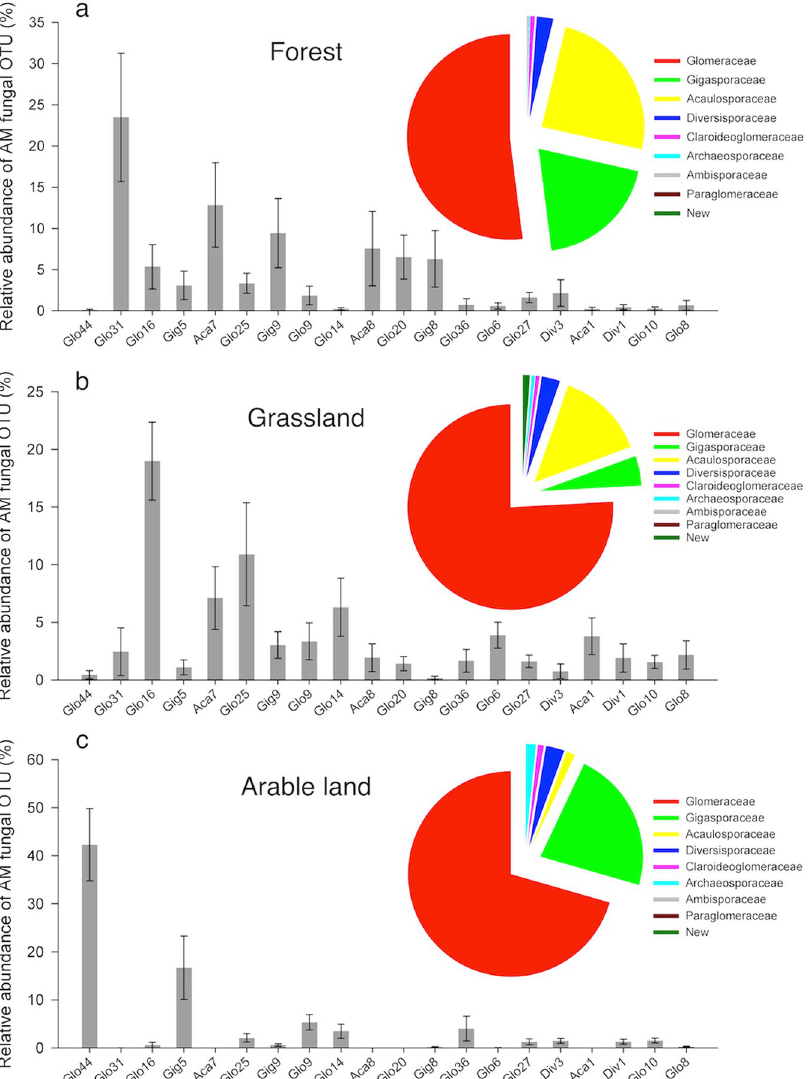
Figure 1. Relative abundance (%) of AM fungal operational taxonomic units (OTUs) in soils sampled from three land use types. The relative abundance of AM fungal OTUs grouped by families, and the relative abundance of 20 dominant AM fungal OTUs (average relative abundance across all samples ≥ 1.1%) in ( a ) forest, ( b ) grassland and ( c ) arable